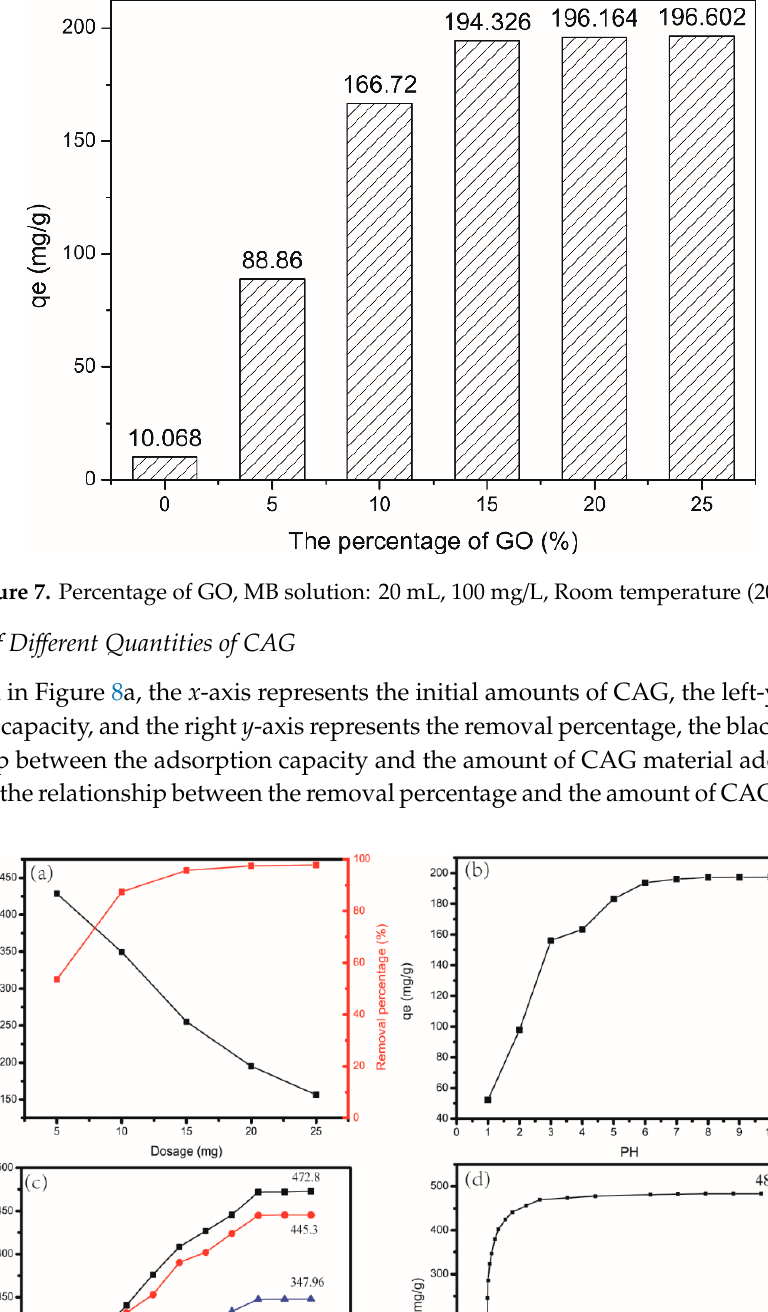
Figure 8. Effect of ( a ) dosage at room temperature (20 °C), MB solution:20 mL, 200 mg/L,.( b ) pH 1–10, MB solution: 20 mL, 100 mg/L, room temperature (20 °C), ( c ) temperature, MB solution: 20 mL, 120–